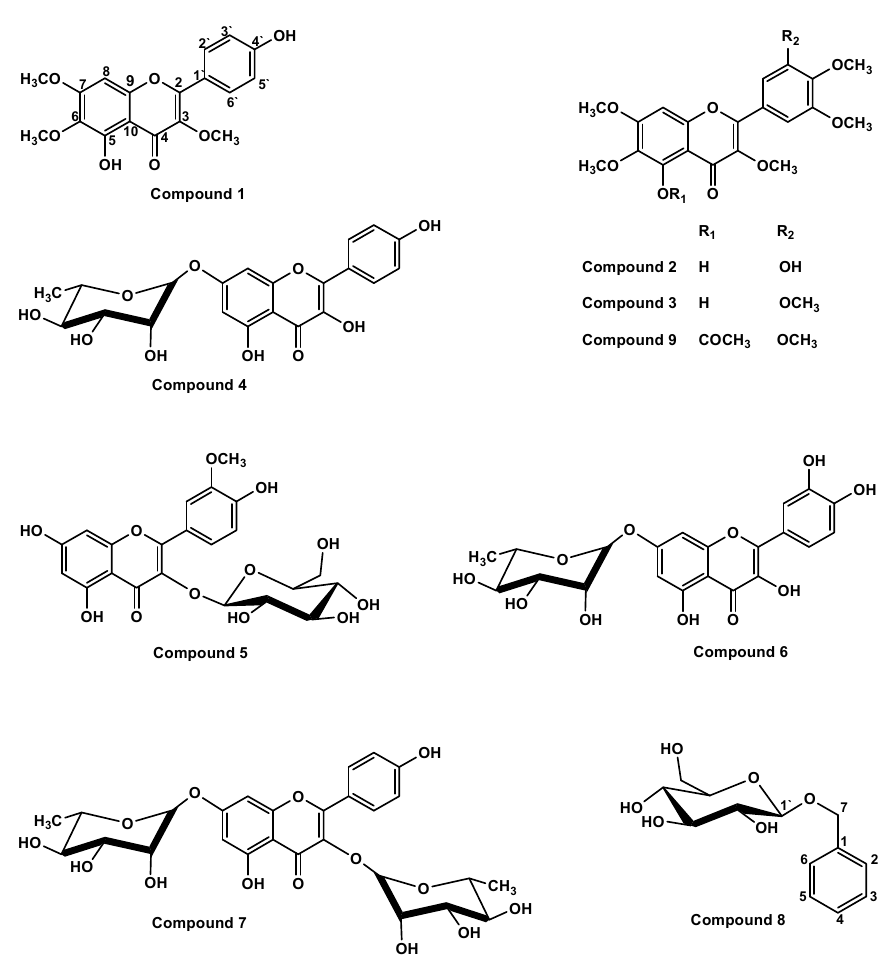
Figure 1. Chemical structures of compounds 1 – 9